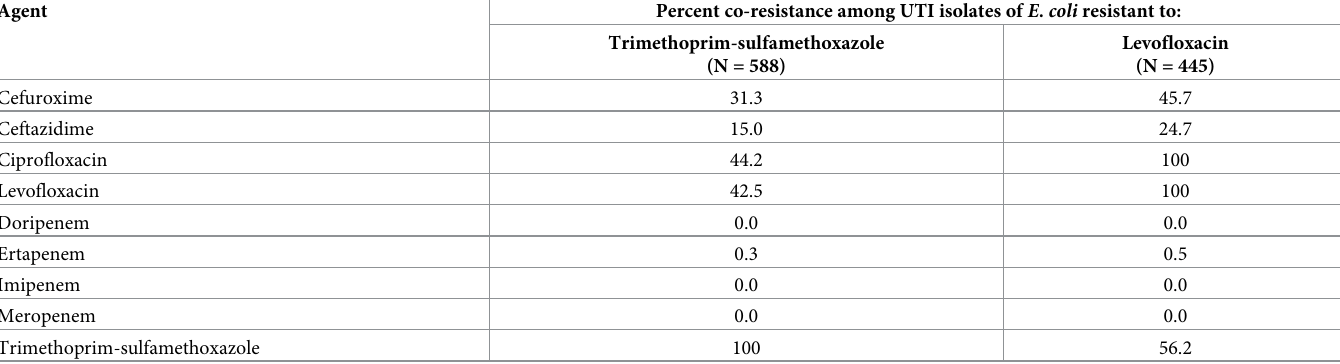
Table 2. Co-resistance among trimethoprim-sulfamethoxazole-resistant and levofloxacin-resistant E . coli from urinary tract infections collected in the USA in 2017. Agent Percent co-resistance among UTI isolates of E . coli resistant